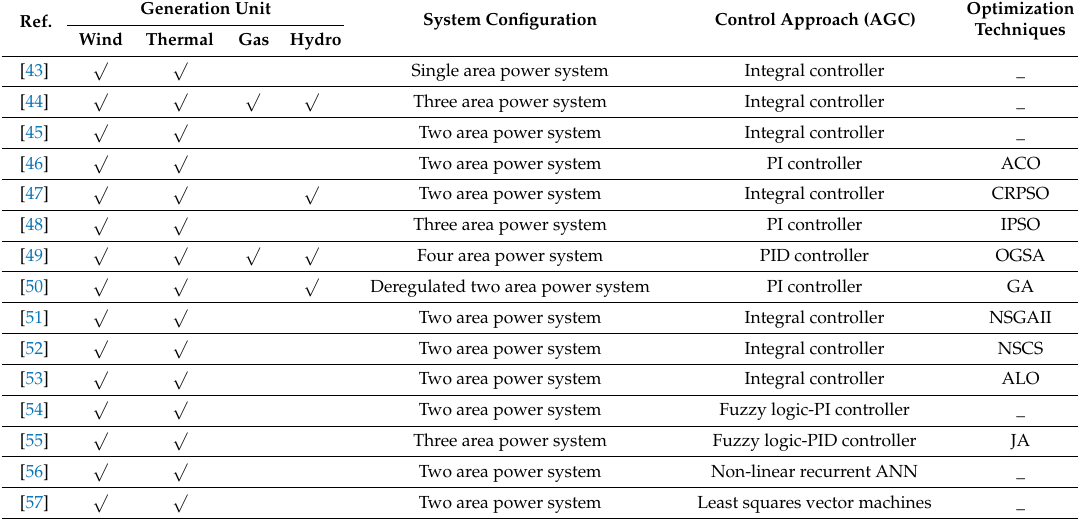
Table 1. Review of papers in wind farm contribution in